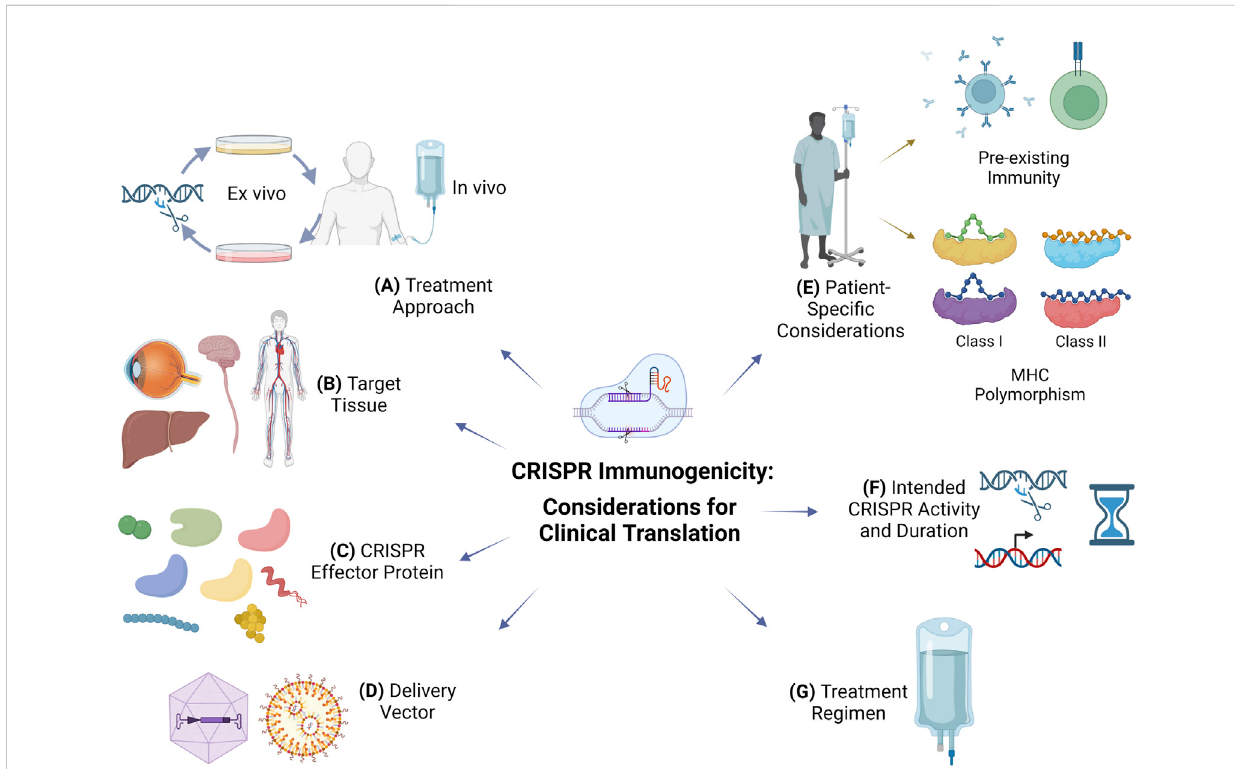
FIGURE 1 Considerations to mitigate immunogenicity for clinical translation of CRISPR therapeutics. (A) Treatment approach: ex vivo gene editing poses a smallerriskofimmunogenicitythan invivo administrationbuthaslimitedutilityfordiseasesrequiringsystemicdeliveryofCRISPRcomponents. (B) Target tissue: CRISPR administration in immune-privileged sites may limit immunogenicity. (C) CRISPR effector protein: non-cross-reactive CRISPR effector protein orthologs from non-ubiquitous bacteria or archaea can be considered for repeated dosing or in individuals with pre-existing immunity. (D) Deliveryvector:viralvectorsaremoreef fi cientthannon-viralvectorssuchaslipidnanoparticlesbutimmunogenicityandorthologcross-reactivitycould limit repeated administration; viral vector tissue tropism can be used for targeting, which reduces the dose and systemic immune responses. (E)